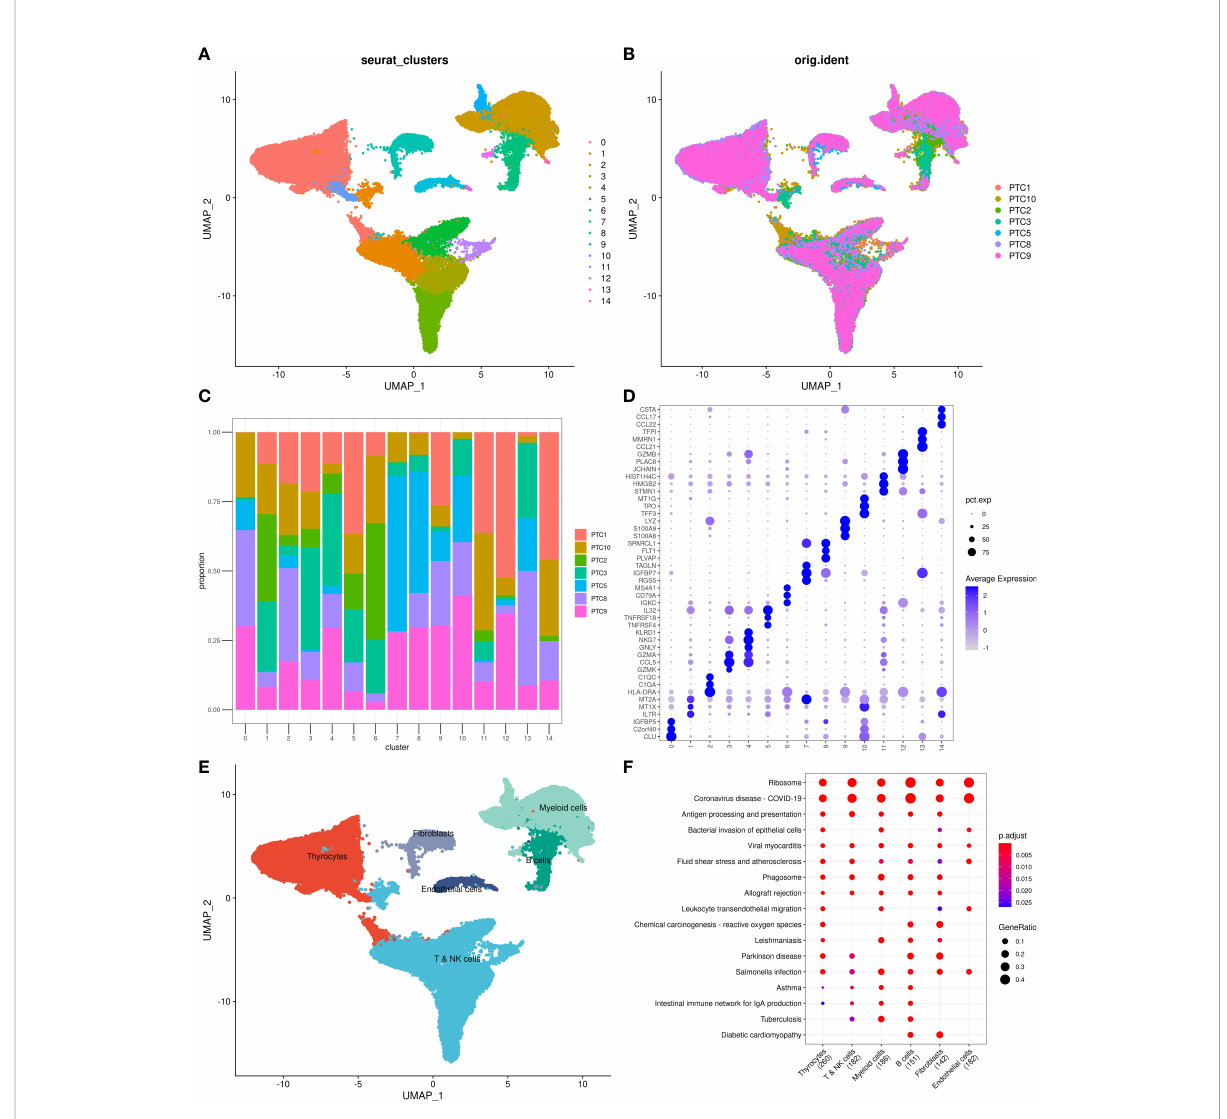
FIGURE 1 Overview of identi fi ed single cells. (A) UMAP of cell pro fi les; different color blocks represent related cell clusters. (B) UMAP of cell pro fi les; different color blocks represent related sample sources. (C) Sample distribution of 15 cell clusters. (D) Heatmap showing marker genes for each cluster, highlighting selected marker genes for each cluster. (E) UMAP of cell pro fi les; different color blocks represent related cell types. (F) Function enrichment of markers for cell subsets. UMAP, Uniform Manifold Approximation and